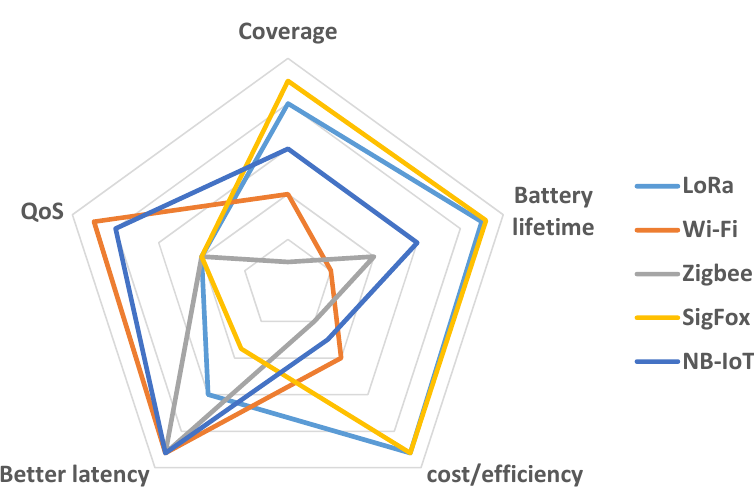
Figure 5. Main features of these technologies.